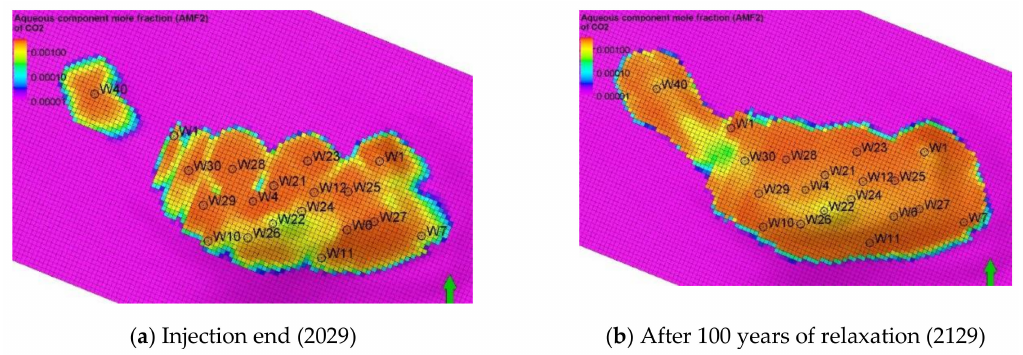
Figure 50. Distribution of CO 2 solution in brine along the vertical cross section (A–A’).